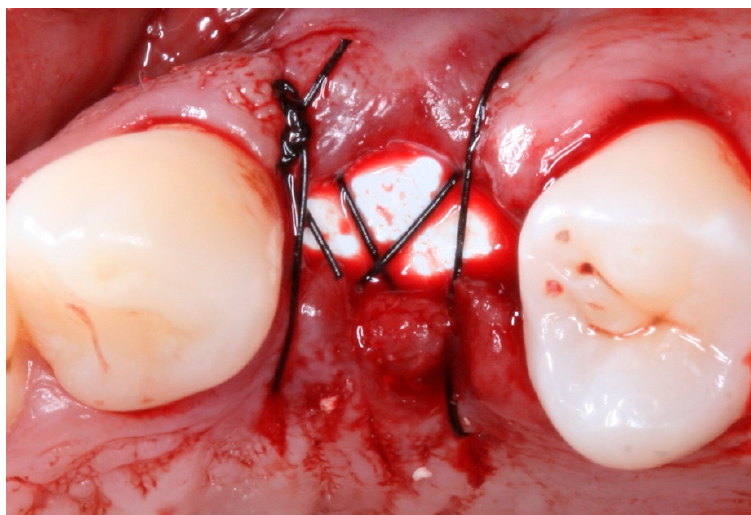
Figure 9. Intraoral occlusal view of the suture-stabilized membrane (TG2).